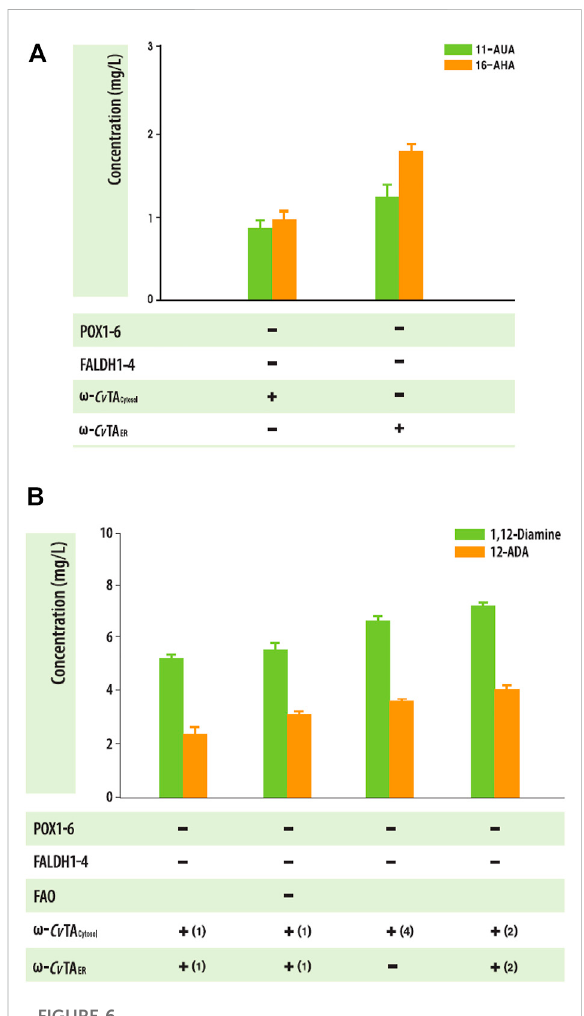
FIGURE 6 (A) Biotransformation of C 11 and C 16 fatty acids into the corresponding ω -amino fatty acids in the engineered Y. lipolytica strains. (B) Effect of Δ FAO1 and copy numbers of ω -TA on the productionofamine-compoundproductioninengineered Y. lipolytica . Error bars represent the standard error of the mean of at least three independent